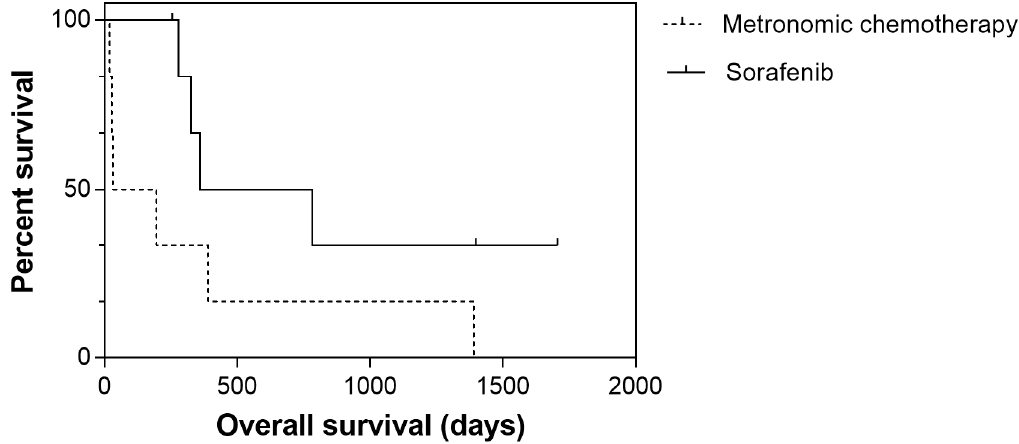
Figure 5. Overall survival for 13 dogs with hepatocellular carcinoma treated with sorafenib (solid line) or metronomic chemotherapy (dashed line). Median overall survival was 361 days for the sorafenib group and 32 days for the metronomic chemotherapy group; however, the difference was not statistically significant ( p = 0.079).